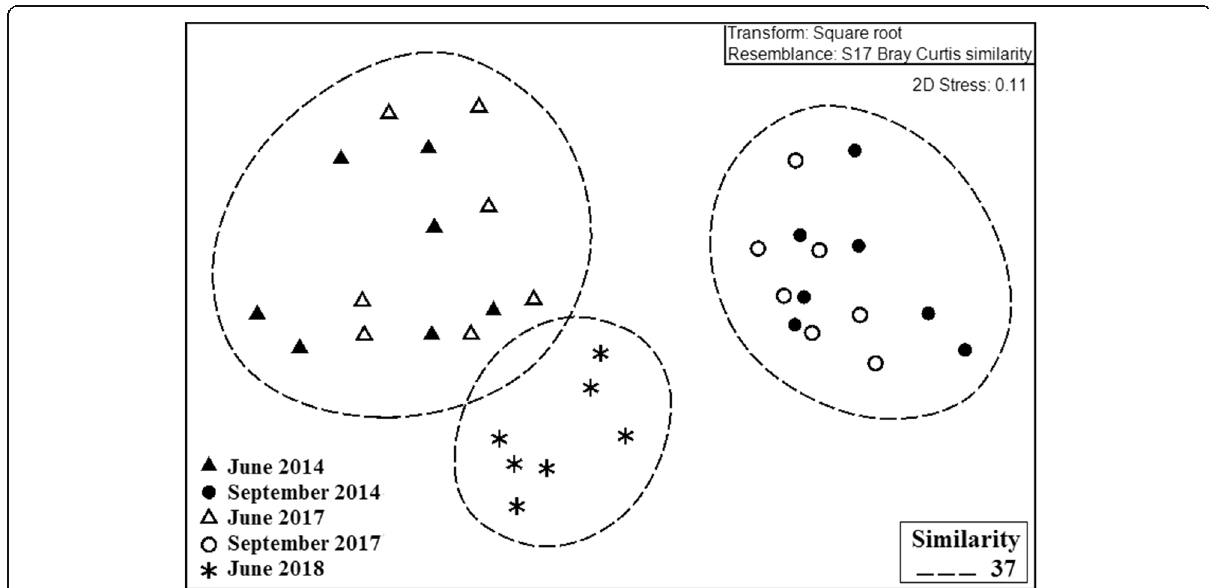
Fig. 6 Nonmetric multidimensional scaling ordination (nMDS) showing sample similarity based on Bray-Curtis distances. Sampling displaying ≥ 37% similarity between sample species composition are